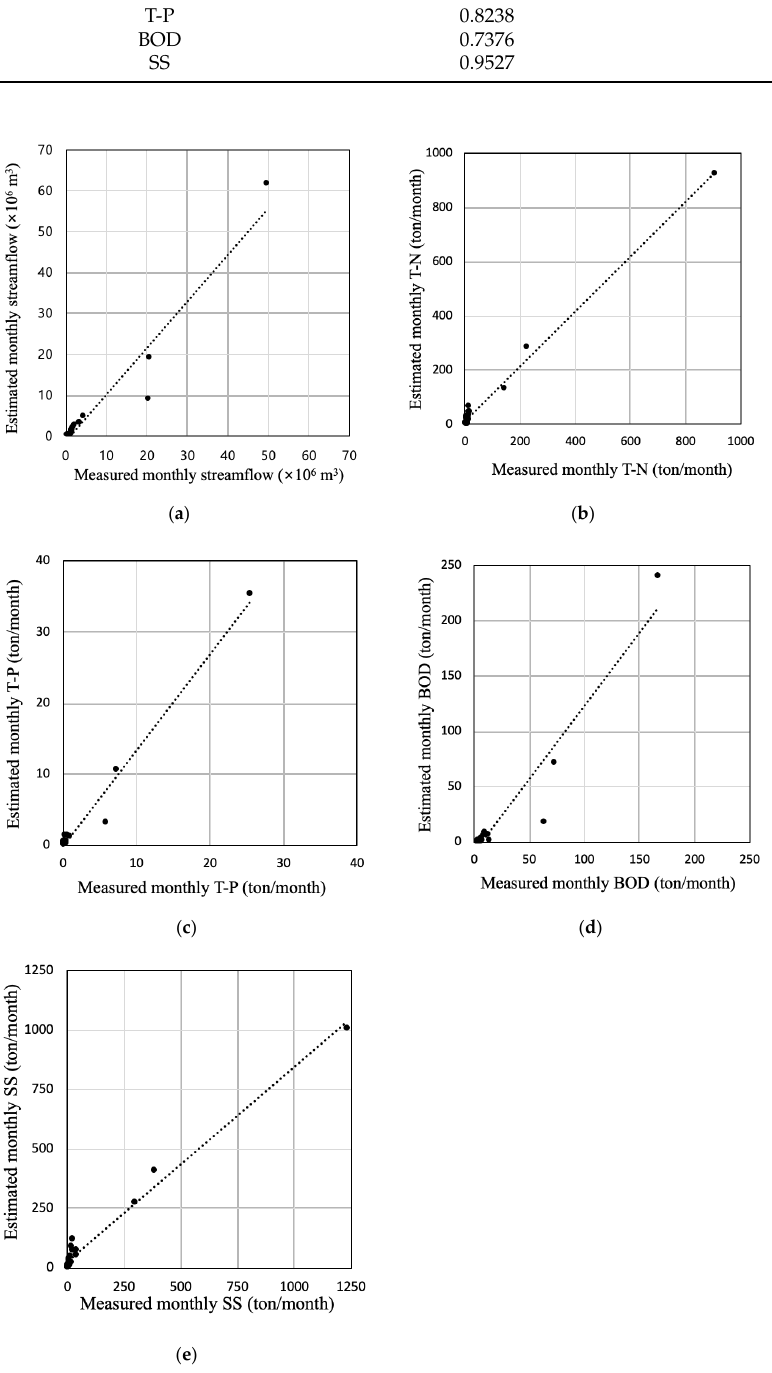
Figure 8. Scatter plots of measured and estimated monthly streamflow and nutrients in model calibration: ( a ) streamflow; ( b ) T-N; ( c ) T-P; ( d ) BOD; ( e ) SS.